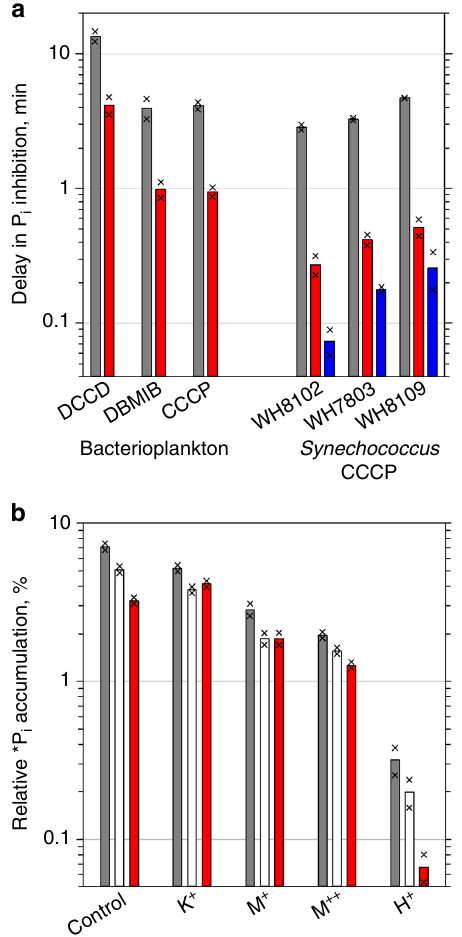
Fig. 8 Inhibition of bacterial P i accumulation. a Comparison of the time delay in the inhibition of *P i accumulation between bacterioplankton treated with DCCD, DBMIB and CCCP, and Synechococcus strains WH8102, WH7803 and WH8109 treated with CCCP. The time delay is derived from the rate of P i accumulation, measured for uninhibited control cells. b Relative P i accumulation in Synechococcus sp. WH8102 cells treated with the K + -speci fi c ionophore Valinomycin (K + ), the monovalent metal- speci fi c ionophore Monensin (M + ), the divalent metal-speci fi c ionophore A23187 (M ++ ) and the protonophore CCCP (H + ). Plots show the results of representative experiments. Bars present mean values of technical duplicates indicated as crosses. Horizontal grey lines indicate major ticks of the logarithmic Y-axis to assist comparing values for the following treatments: P i accumulation into live cells washed with seawater (grey bars), into PFA- fi xed cellular macromolecules (red bars) and into TCA- fi xed cellular nucleic acids (blue bars) ( a ) or into the cytoplasm (white bars) of cells washed with deionized water ( b ). Source data are provided as a Source Data fi le.